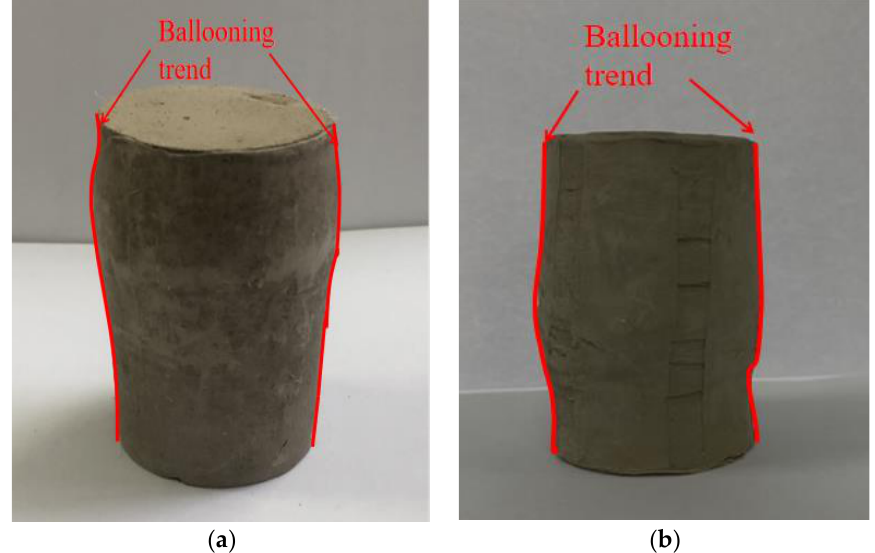
Figure 16. Friction failure specimen. ( a ) Fiber reinforced specimen, ( b ) specimen without poly- propylene fiber. lene